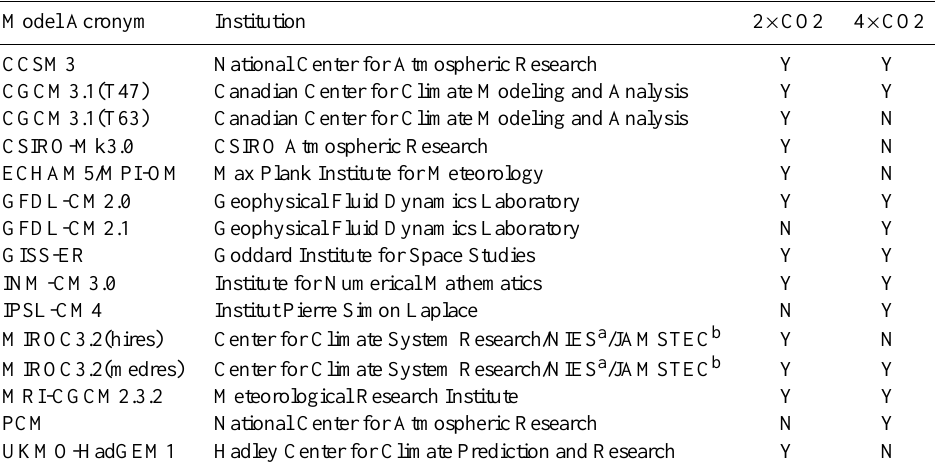
Table 3. Definition of the CMIP3 2 × CO2 equilibrium (slab ocean) and the 1% to 4 × CO2 transient experiments used in this study. A “Y” (“N”) indicates this model was (was not) used for the given